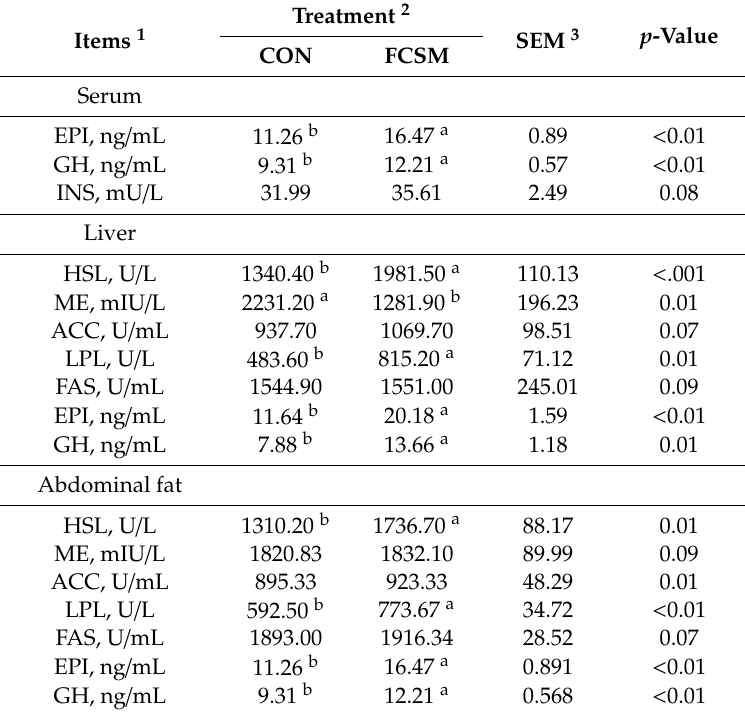
Table 5. Enzyme activity and hormone level in broiler serum, liver, and abdominal